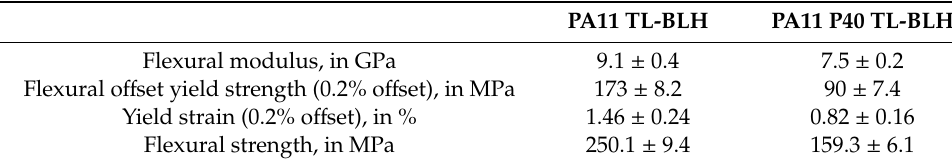
Figure 6. Representative flexural stress-strain curves of PA11 hybrid composites. Table 4. Flexural parameters of PA11 based